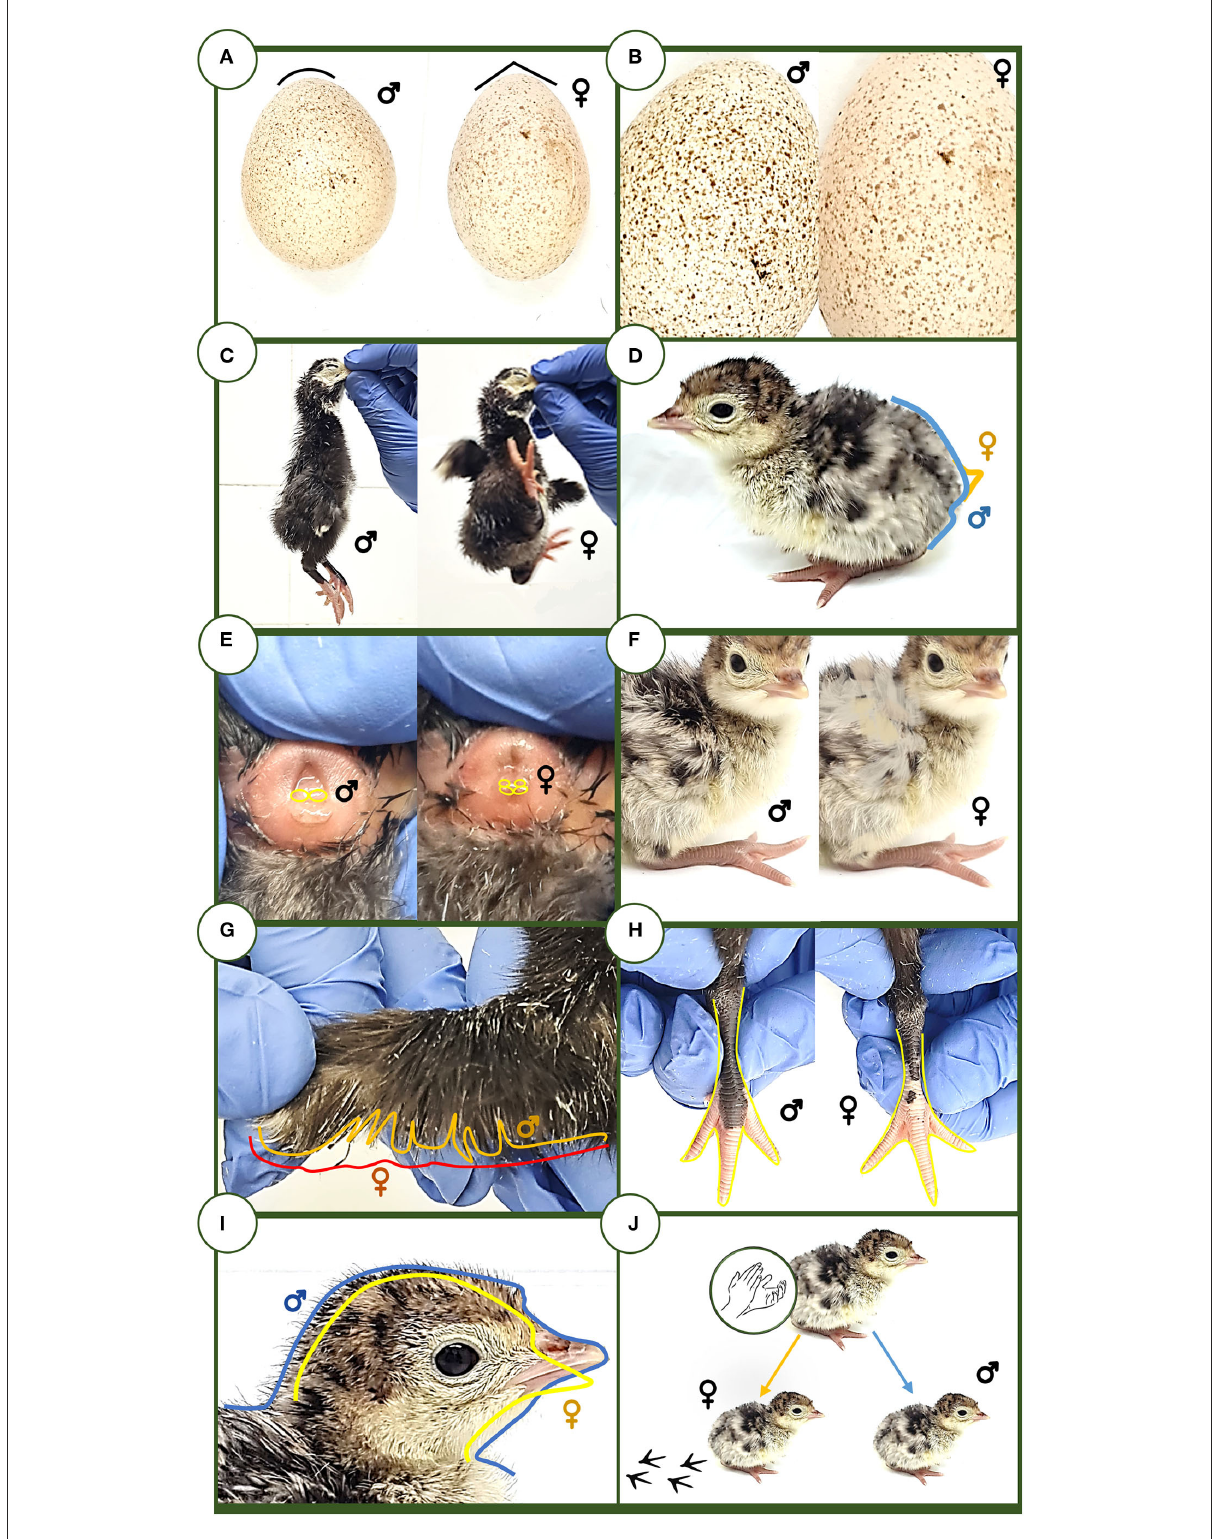
FIGURE1 Sex assignment methods. (A) Egg length and width test. (B) Eggshell color. (C) English test. (D) Tail inclination. (E) Cloaca. (F) Side feathers. (G) Wing fan. (H) Legs. (I) Head size and morphology. (J) Behavior/coping